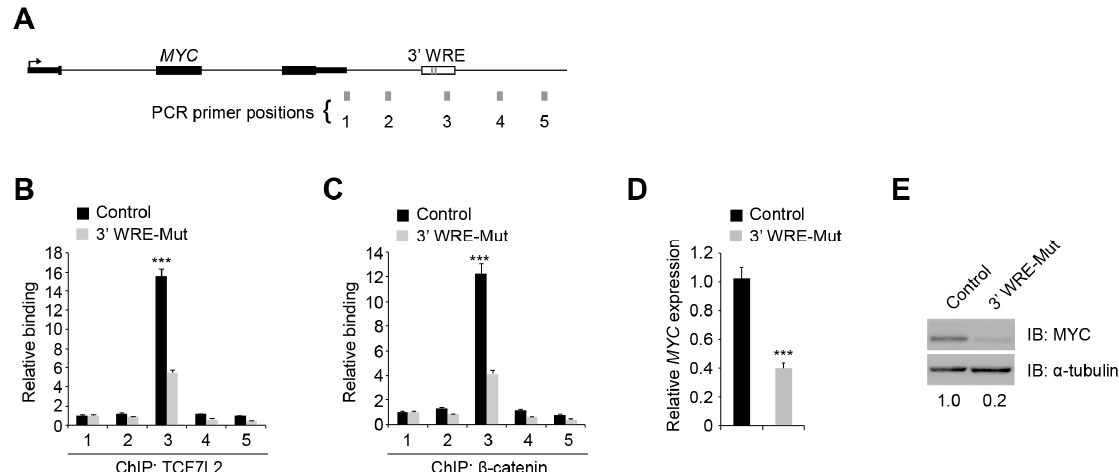
Figure 2. Deleting TBE1 reduces TCF7L2/ β‐ catenin binding to the MYC 3 ′ WRE and MYC expression. ( A ) Diagram of the MYC genomic locus with the positions of PCR amplicons indicated by grey rectangles and labeled 1 ‐ 5; ( B ) qPCR analysis of DNA fragments precipitated with anti ‐ TCF7L2 antibodies in ChIP assays conducted in control and 3 ′ WRE ‐ Mut cells. Shown are signals obtained from PCR amplicons listed on the x ‐ axis. The data is normalized to levels detected with amplicon 1; ( C ) as in ( B ) except anti ‐β‐ catenin antibodies were used in the ChIP assays; ( D ) qRT ‐ PCR analysis of MYC transcript levels detected in control and 3 ′ WRE ‐ Mut cells. The data is normalized to GAPDH levels; ( E ) Western blot analysis of MYC protein levels in control and 3 ′ WRE ‐ Mut cells. The blots were re ‐ probed with anti ‐α‐ tubulin antibodies to control for loading. Shown below are relative levels of MYC, which were quantified using densitometry. Error bars are ±SEM (*** p < 0.001).